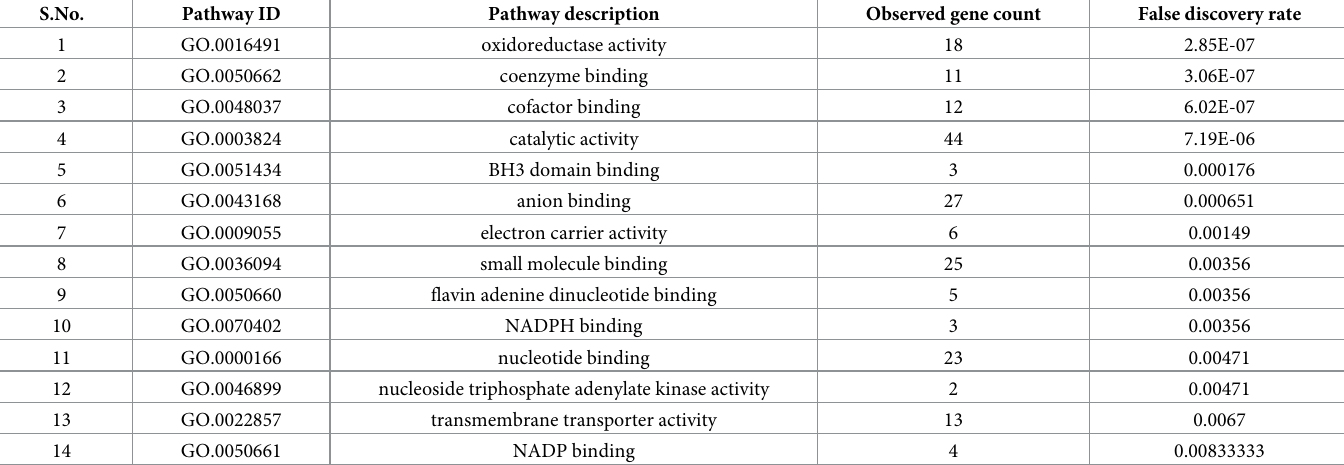
Table 6. The significantly enriched molecular functions (MF) of the RA synovial mitochondrial DEGs. S.No.